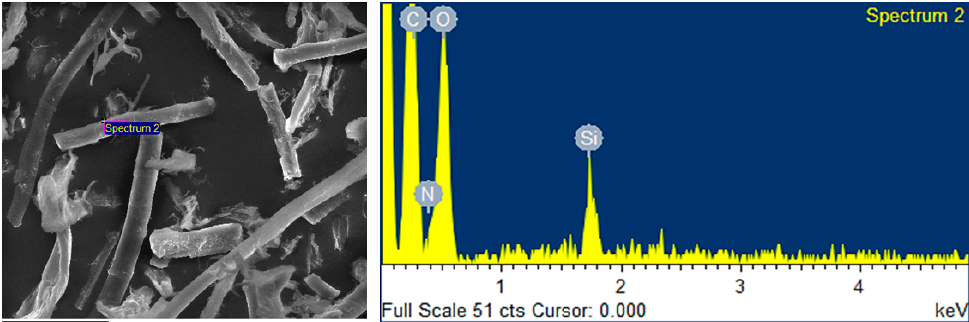
Figure 3. Micrograph of hemp fiber after APTS functionalization and EDX spectrum.